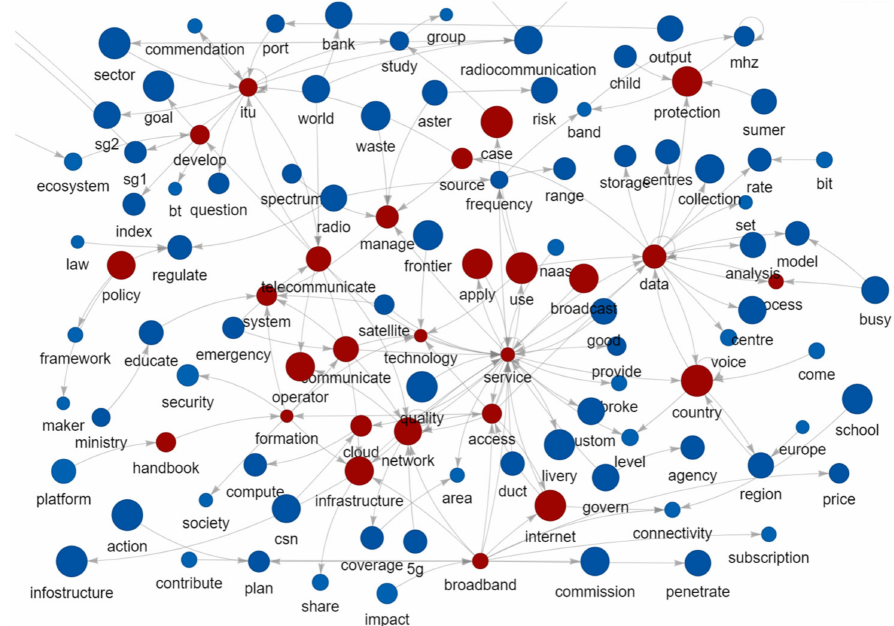
Figure 1. Result of ego network